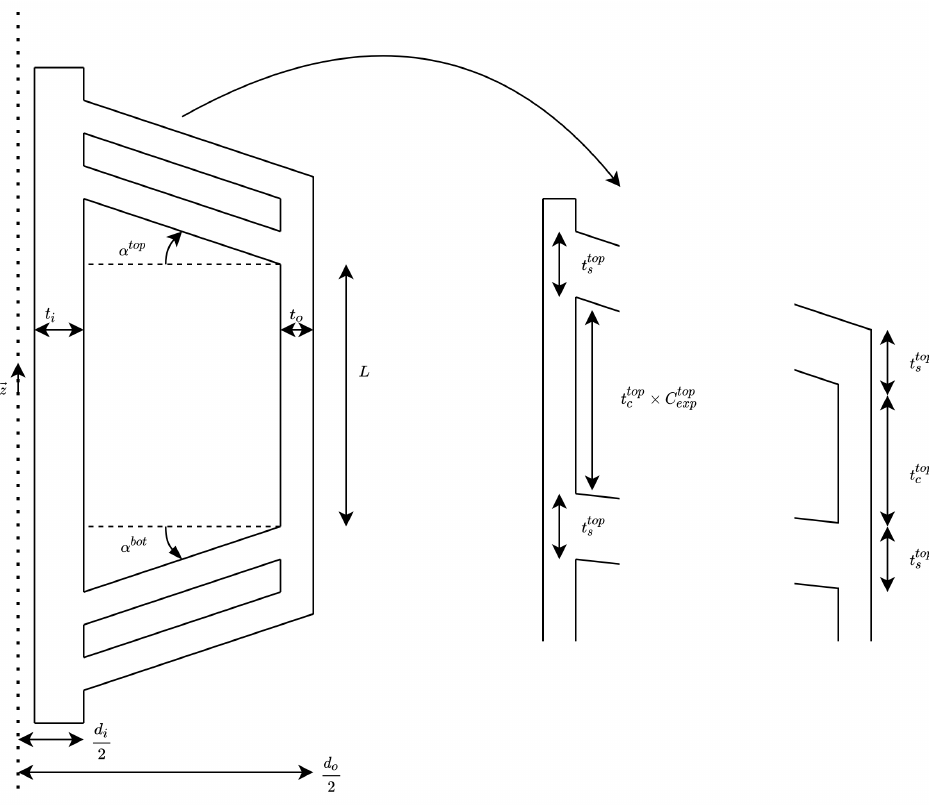
Figure 6. Parametrization of the UBB geometry and illustration of the design variables, for the whole body on the left and details of the covers on the